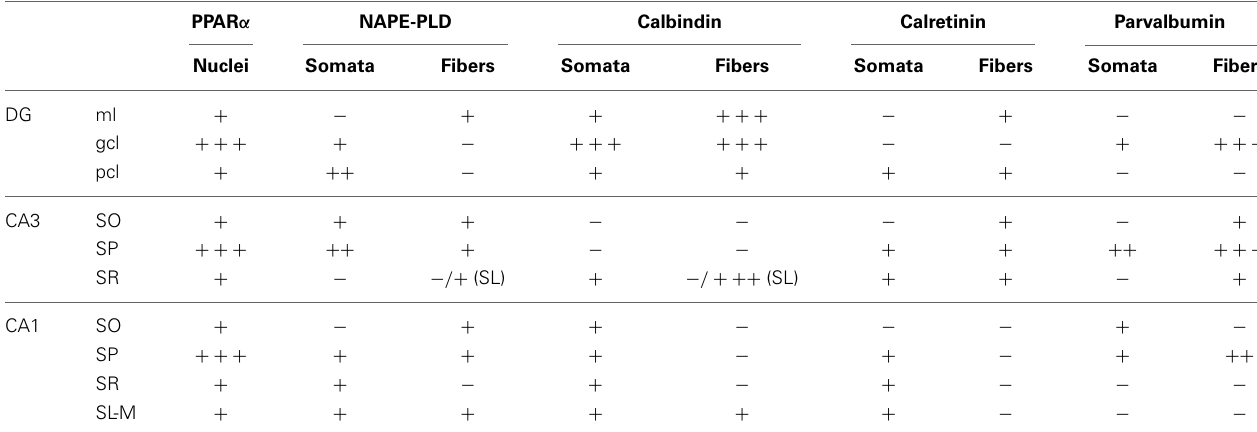
Table 3 | Immunoreactivity in the rat hippocampus a